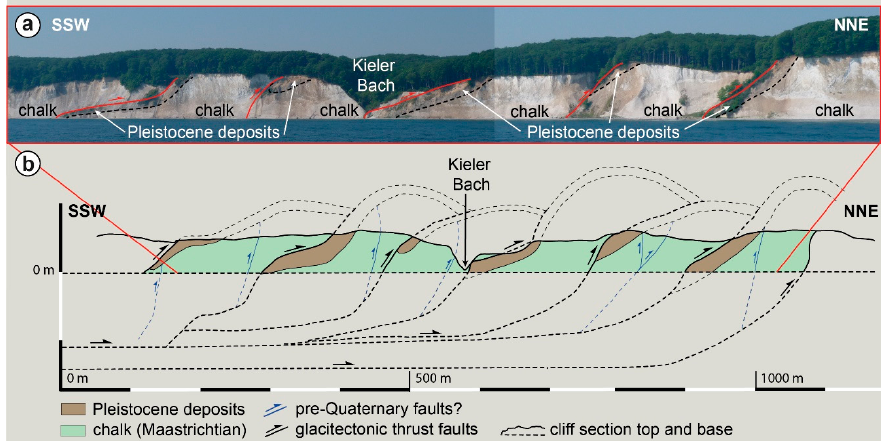
Figure 2. Exemplary outcrop at the creek Kieler Bach showing six thrust sheets of the southern structural sub-complex of Jasmund. ( a ) Overview of the cliff coast SSW and NNE of Kieler Bach (c. 1000 m). The red lines represent the thrust faults. The black dashed lines show the boundary between the Cretaceous (Maastrichtian) chalk and the Pleistocene deposits; ( b ) Cross section of the same outcrop with interpreted thrust faults, anticlines and detachment surfaces above and below the cliff boundaries. The black thrust faults are highly likely related to the glacitectonic deformation in the Upper Weichselian, while the blue reverse faults could also be of pre-Quaternary age (see e.g., [44]). For simplification, the youngest Pleistocene till complex (M3) covering parts of the glacitectonized sequence at the cliff top has not been incorporated in the cross section.